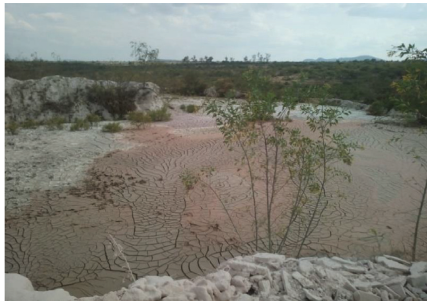
Figure 1: Accumulation of sludge (own source).